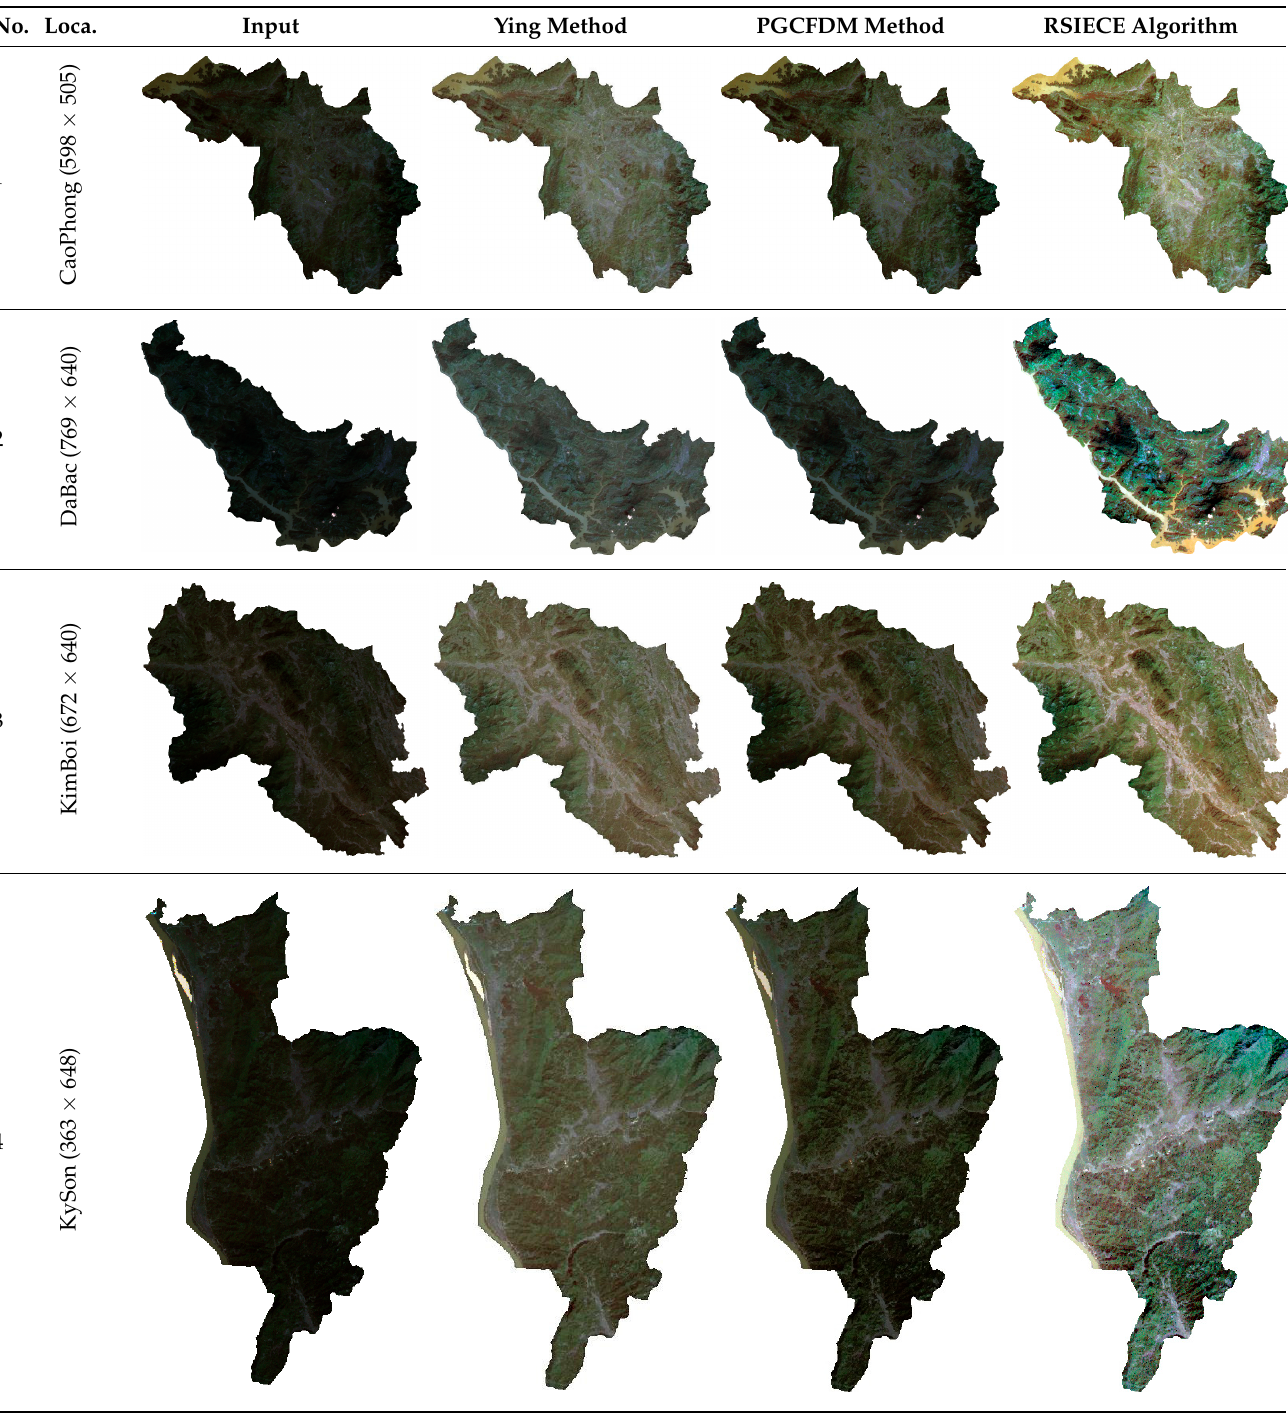
Table 2. Brief information on experimental images from this study. No. Loca.